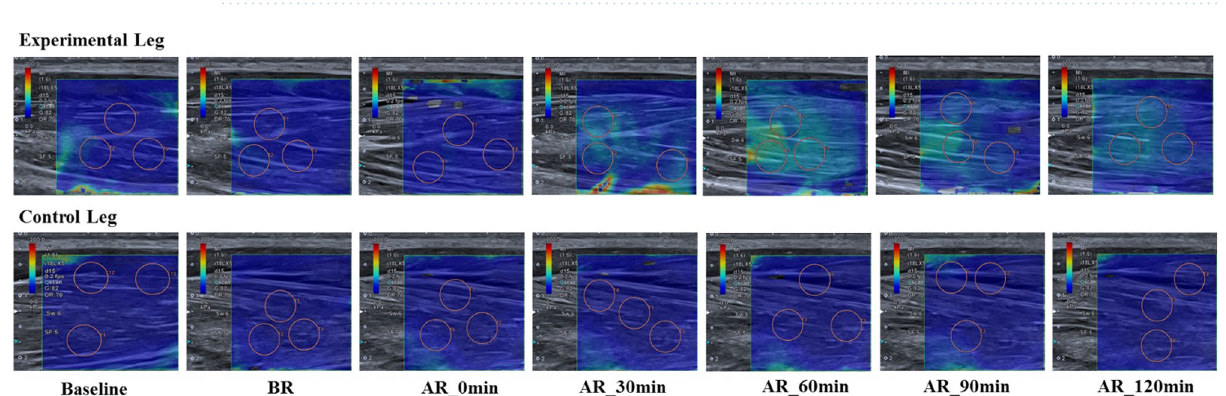
Figure 4. A representative shear wave elastography images of the experimental leg and control leg at each time point. Every three pink circles per image indicate the random region of interest for further data